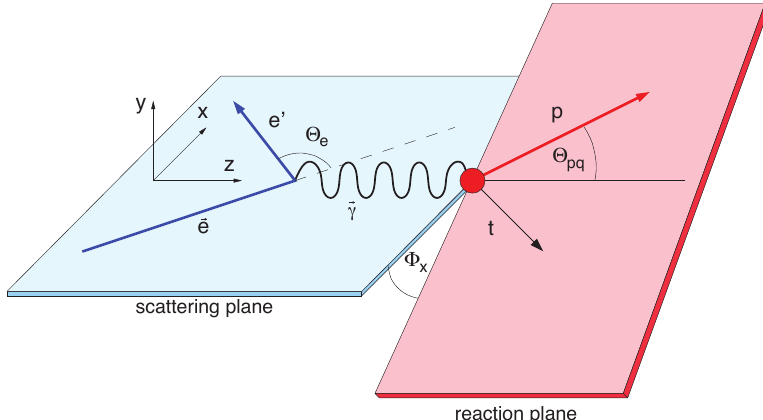
Fig. 1. Schematic of the 4 He( e , e (cid:2) p ) 3 H reaction. The components of the proton recoil polarization are recon- structed in a coordinate system where the z axis is along the three-momentum transfer, q , the y axis is perpen- dicular to the scattering plane, and the x axis is in the scattering plane perpendicular to the momentum transfer, forming a right-handed